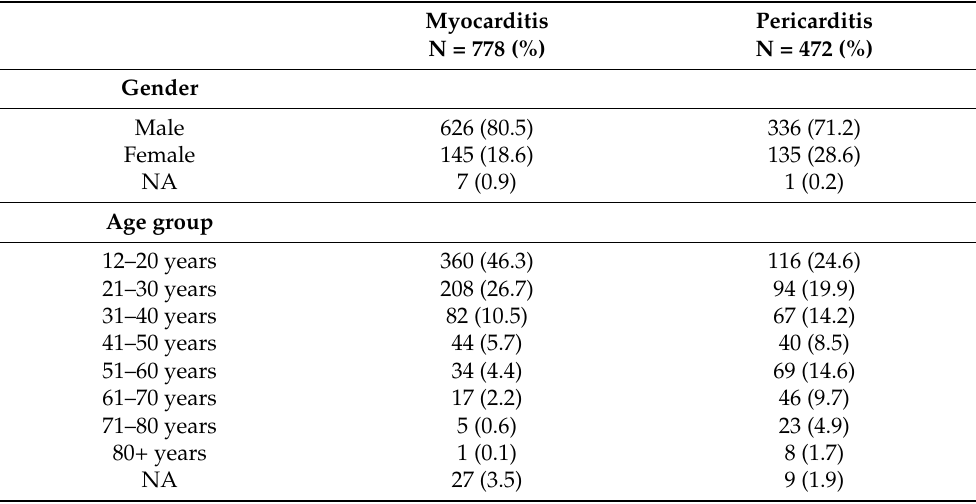
Table 1. Demographic characteristics of ICSRs reporting cases of myocarditis and pericarditis followed by COVID-19 immunization with mRNA vaccines. The outcomes are not mutually exclusive.